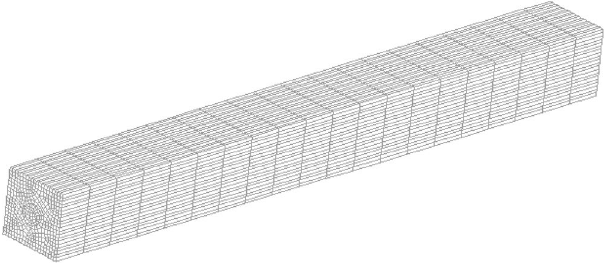
Figure 1. Three-dimensional grid meshed using unstructured hexahedral